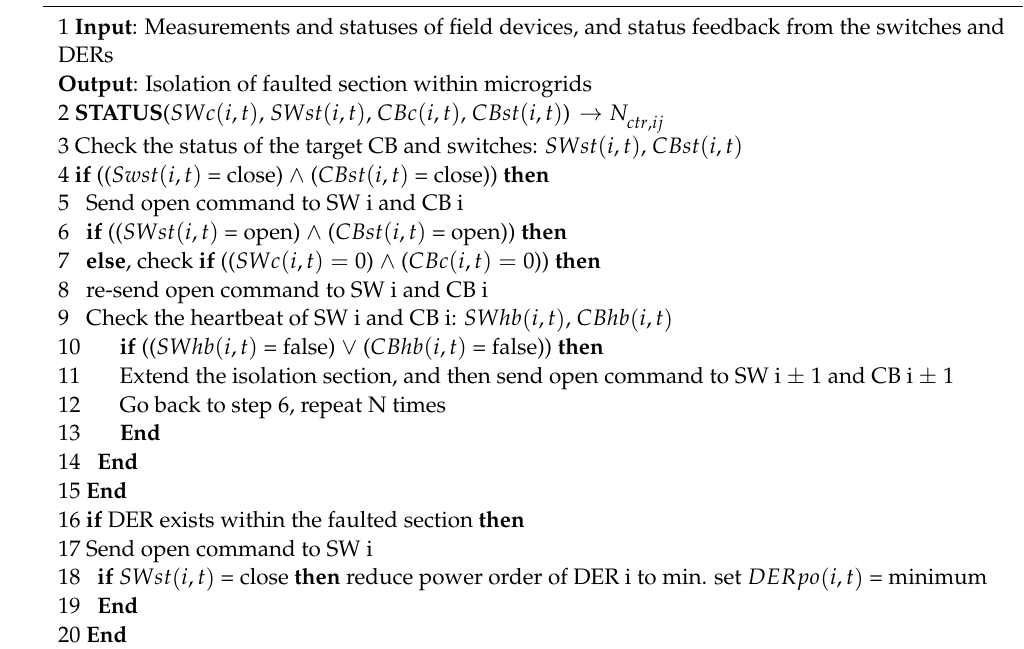
Algorithm 2. Faulted Section